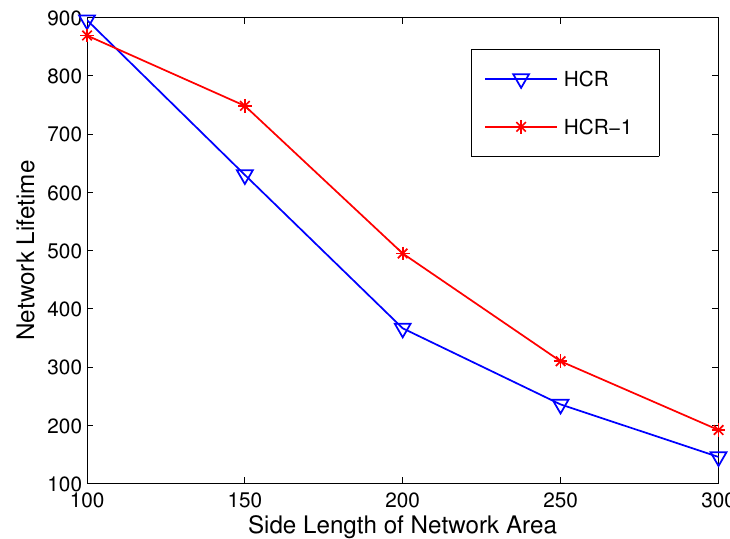
Figure 10. Network lifetime comparison with different network areas.